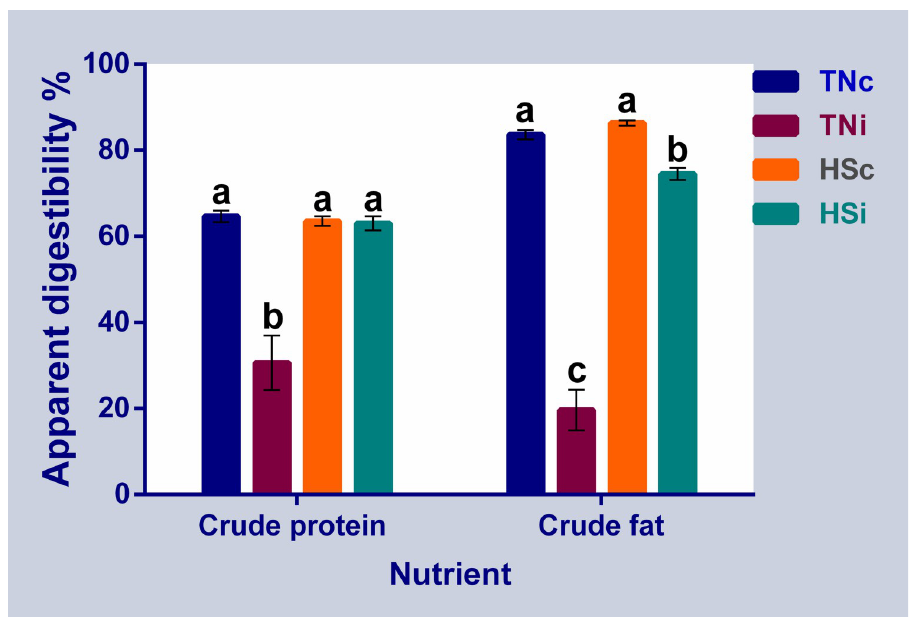
Fig 3. Chickens’ ileal crude protein and fat digestibility. The crude protein and crude fat apparent ileal digestibility at 6 dpi of chickens infected with E . maxima and their uninfected controls that are raised in a thermoneutral or heat stress environment: TNc = thermoneutral control, TNi = thermoneutral infected, HSc = heat stress control, HSi = heat stress infected. Significant differences (p < 0.05) were depicted by different letters. The error bars represent the SEM.